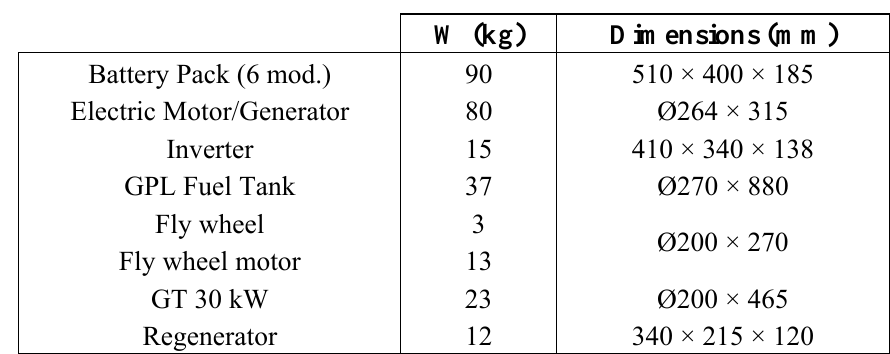
Table 8. City Car Configuration.